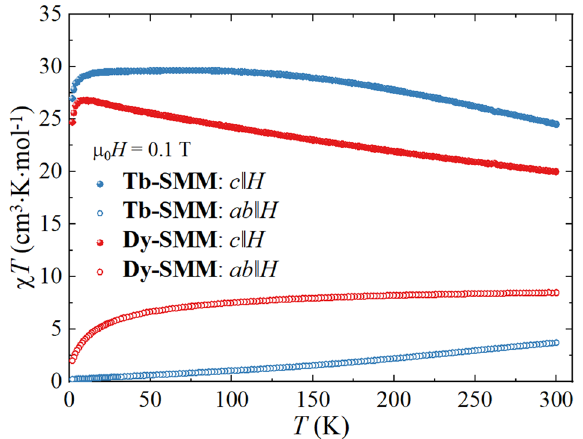
Figure 3. The product of molar magnetic susceptibility and temperature χ T for Tb-SMM and Dy-SMM measured in function of temperature from 300 to 2 K for c ∥ H and ab ∥ H orientations in the static magnetic field µ 0 H = 0.1 T.